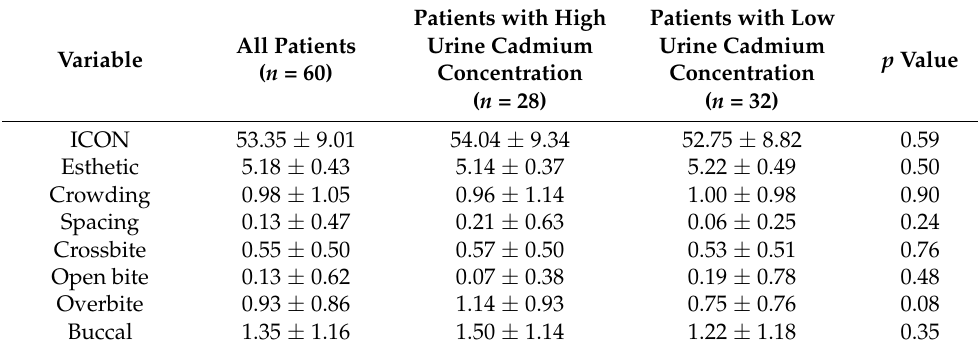
Table 5. Index of complexity outcome and need (ICON) scores of orthodontic patients, stratified according to their urine cadmium concentrations as high or low ( n = 60).